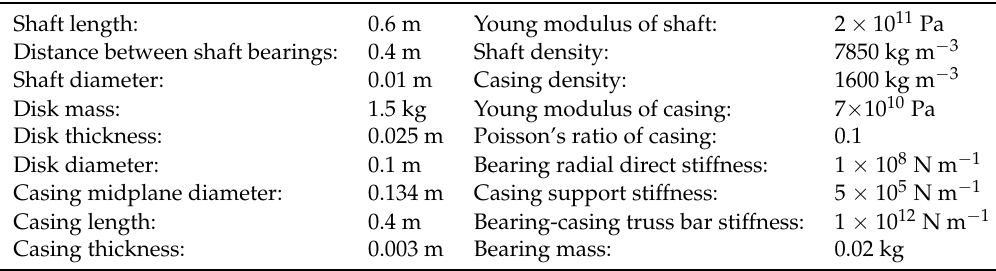
Table 1. Rotor–casing model dimensions and mechanical